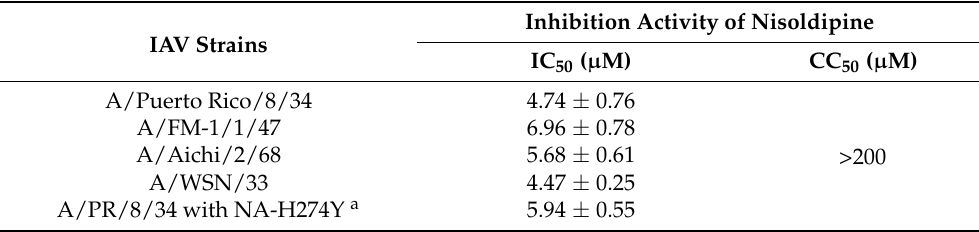
Table 2. Inhibitory activities of nisoldipine against multiple influenza virus strains (mean ± SD, n = 3).